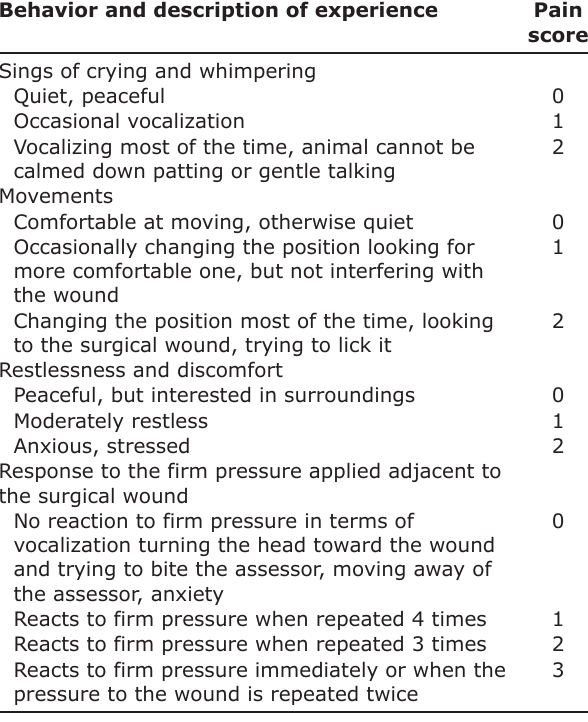
Table-1: Multifactorial pain scale [26].